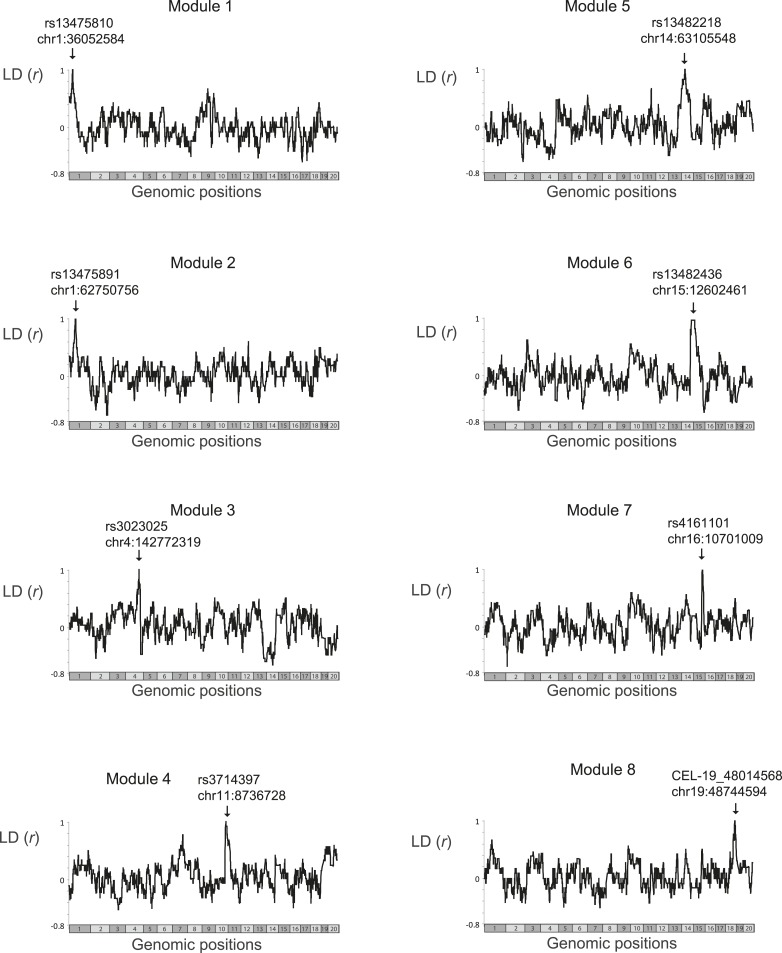
Linkage disequilibrium.Scatter plots of linkage disequilibrium (correlation coefficient, y-axis) between all variants in the genome (x-axis) and the single representative genetic variant of a single module (marked by arrows). The analysis was applied only on those BXD mouse strains that were profiled in the myeloid gene-expression dataset (Gerrits et al., 2009) and were therefore used by the GEMOT algorithm in this study. Notably, for each module, none of the genomic positions outside its genomic interval was in absolute linkage disequilibrium that is larger than 0.75. Within the module's genomic interval, linkage disequilibrium reached 1, as expected.